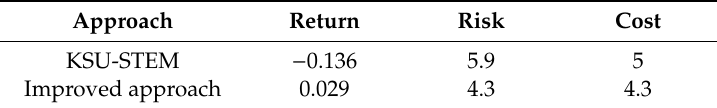
Table 2. Basal values of the objectives via both